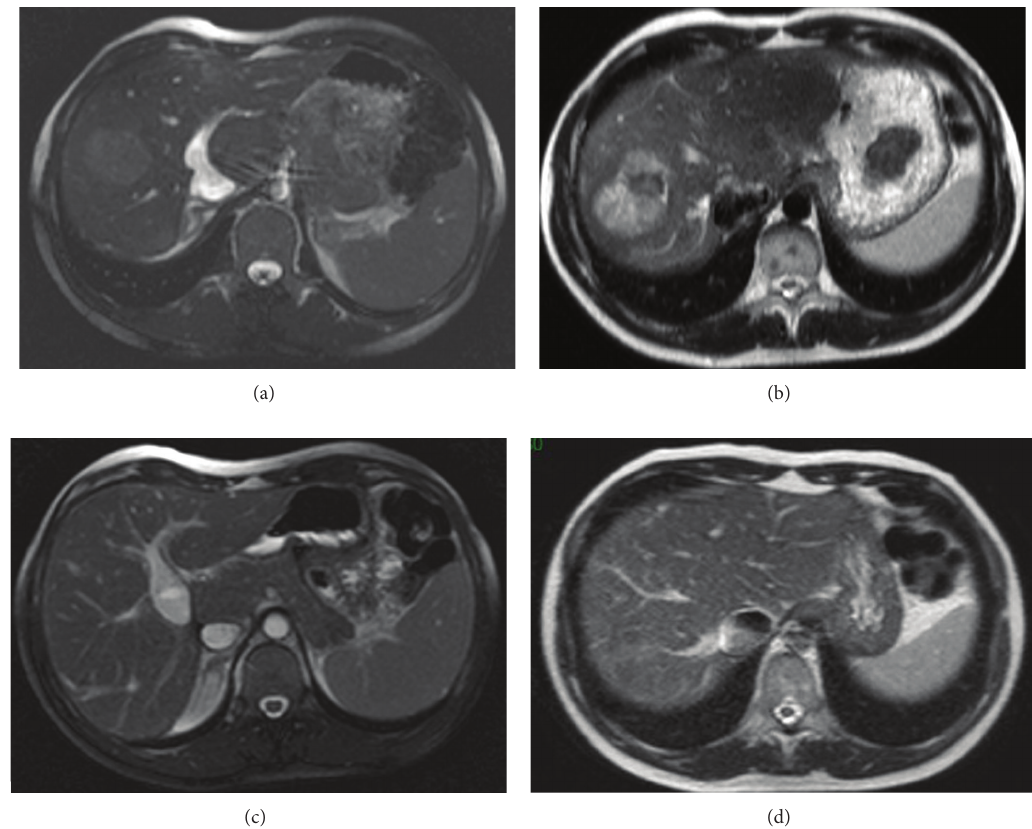
Figure 6: Adenoma associated with CPSS. Aspect on MRI at diagnosis and 10 months after surgical closure of the shunt: (a) T2 WI-balanced sequenceshowstheCPSSconsistingofapatentductusvenosus.Notethatthetumorisnoteasilyvisibleinthissequence.(b)The4 cmdiameter HCA lies in segment 8, and it is better seen on T2 WI and appears heterogeneous and mainly hyperintense compared to the surrounding liver. MRI performed 10 months after surgical closure of the shunt (c) shows the complete disappearance of the tumor